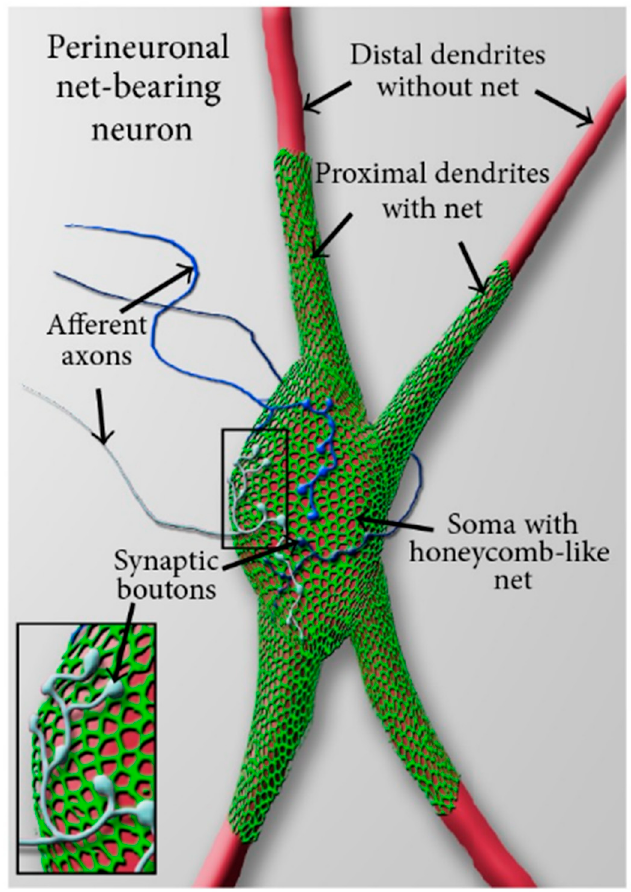
Figure 2. Adapted, with permission, from [143]. Schematic view of a perineuronal net-bearing neuron. A neuronal cell body (soma) with its proximal dendrites (red) covered by a typical reticular, honeycomb—like net (green). More distally, dendrites are devoid of nets. The holes in the perineuronal nets are occupied by synaptic boutons of afferent axons (insert, blue) that synapse on the net-bearing neuron.